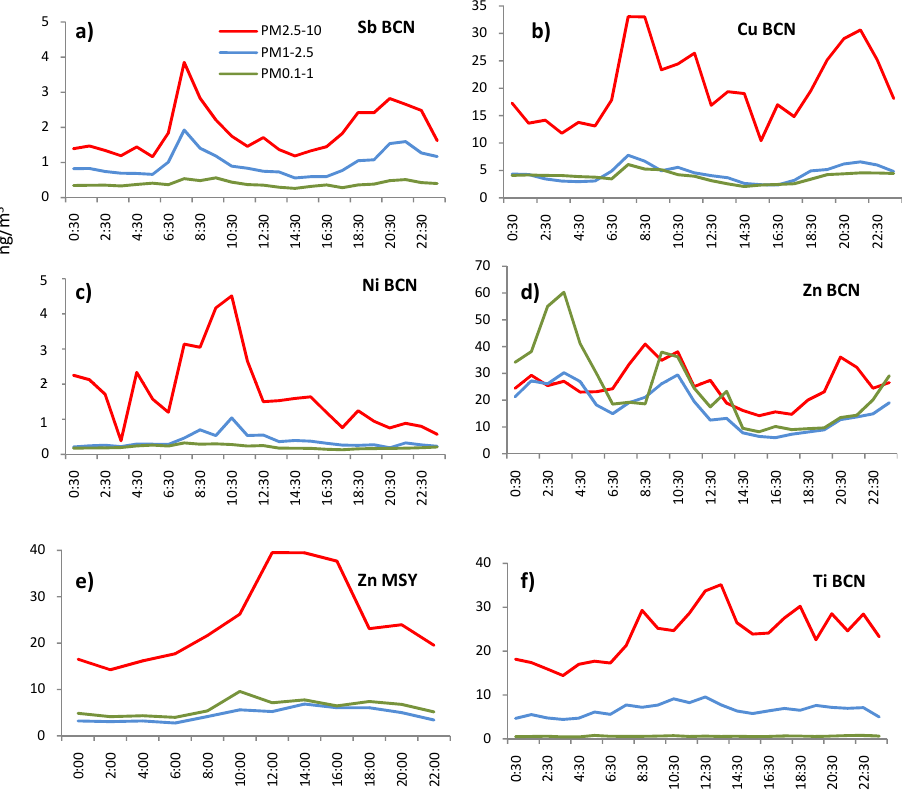
Fig. 6. Different daily cycles of metal concentrations from hourly levels recorded by the rotating drum impactor in three different PM size fractions (0.1–1, 1–2.5 and 2.5–10µm) during the winter campaign. (a) Sb in Barcelona (mainly traffic); (b) Cu in Barcelona (mainly traffic); (c) Ni in Barcelona (mainly industrial); (d) Zn in Barcelona (traffic and industry); (e) Zn in Montseny (traffic and industry); (f) Ti in Barcelona (mainly